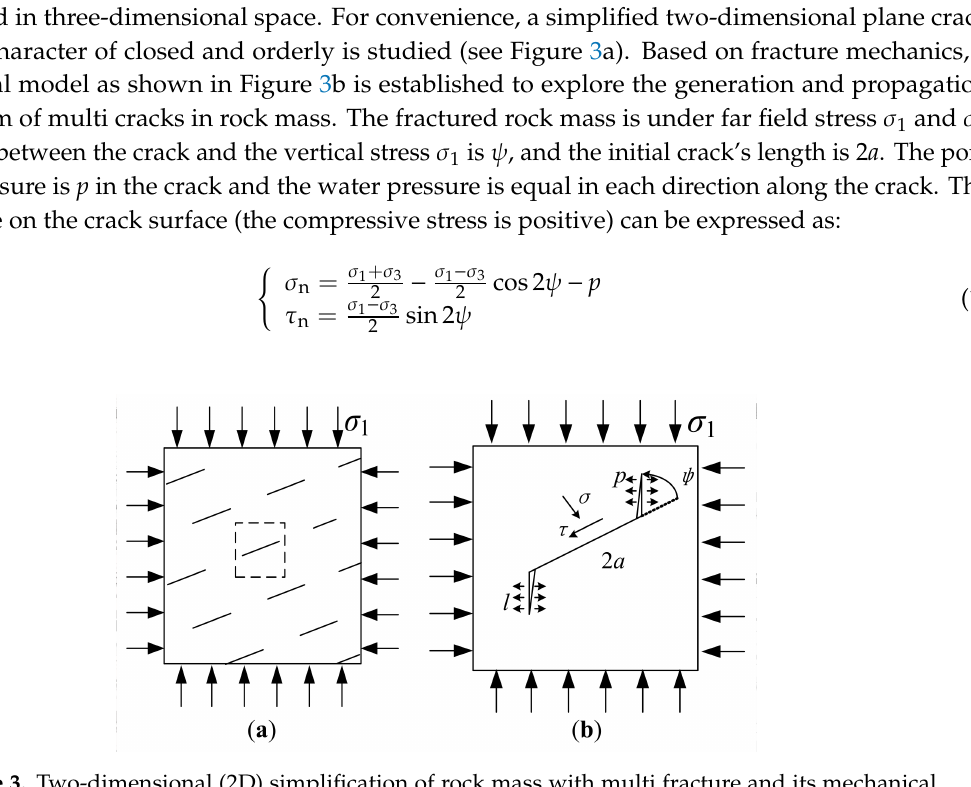
Figure 3. Two-dimensional (2D) simplification of rock mass with multi fracture and its mechanical model. ( a ) The 2D simplification of rock mass with multi fracture; ( b ) The mechanical model of rock mass with multi